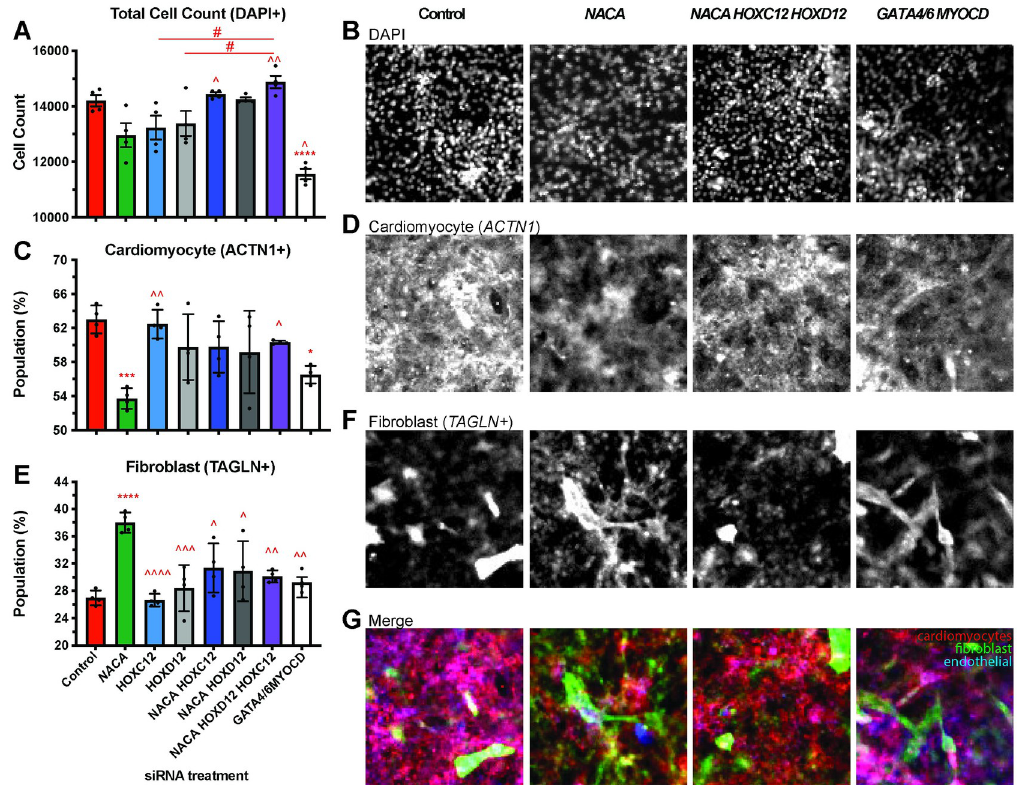
Fig 5. Nac α and Hox genes interact to redirect differentiation of Multipotent Cardiac Progenitors (MCPs). A,C,E, Quantitation of differentiated cell populations 9 days after siRNA treatment. B,D,F. Representative images of immunohistological staining for select conditions. A,B, Total Cell Populations following siRNA treatment were not significantly changed compared to controls, except for Gata4/6 , MyoCD siRNA condition which reduced overall cell count. Knockdown (KD) of Nac α (green), HOXC12 (light blue), HOXD12 (light gray) singly resulted in cell populations that trended lower. This decrease was reversed and significantly different upon combined transfection of Nac α siRNAs with Hox genes, compared to single siRNA transfections. C,D, Nac α KD alone significantly decreased the proportion of cardiomyocytes (ACTN1+) compared to controls, while treatment with HOXC12 or HOXD12 siRNA individually, had no effect. Combined transfection of Nac α and Hox genes reversed the decrease in cardiomyocyte population and was significantly different compared to Nac α KD alone and no longer different compared to controls. Gata4/6 , MyoCD KD also significantly lowered the proportion of cardiomyocyte populations. E,F, Nac α KD increased the proportion of fibroblasts (TAGLN+) compared to controls. Combined KD of Nac α with any of the Hox genes did not alter fibroblasts numbers compared to controls but were significantly reduced compared to Nac α KD alone. G, Images of merged staining of cardiomyocyte, fibroblast, and endothelial cells shows the decrease in cardiomyocyte (red) and increase in fibroblast (green) staining when NACA is knocked down compared to controls. This is reversed upon co-KD with HOXC12 and HOXD12 . Significance � vs. control. ^ vs. Nac α . # comparison is indicated by line. � p < 0 . 05 , �� p < 0 . 01 , ��� p < 0 . 001 , ���� p < 0 . 0001